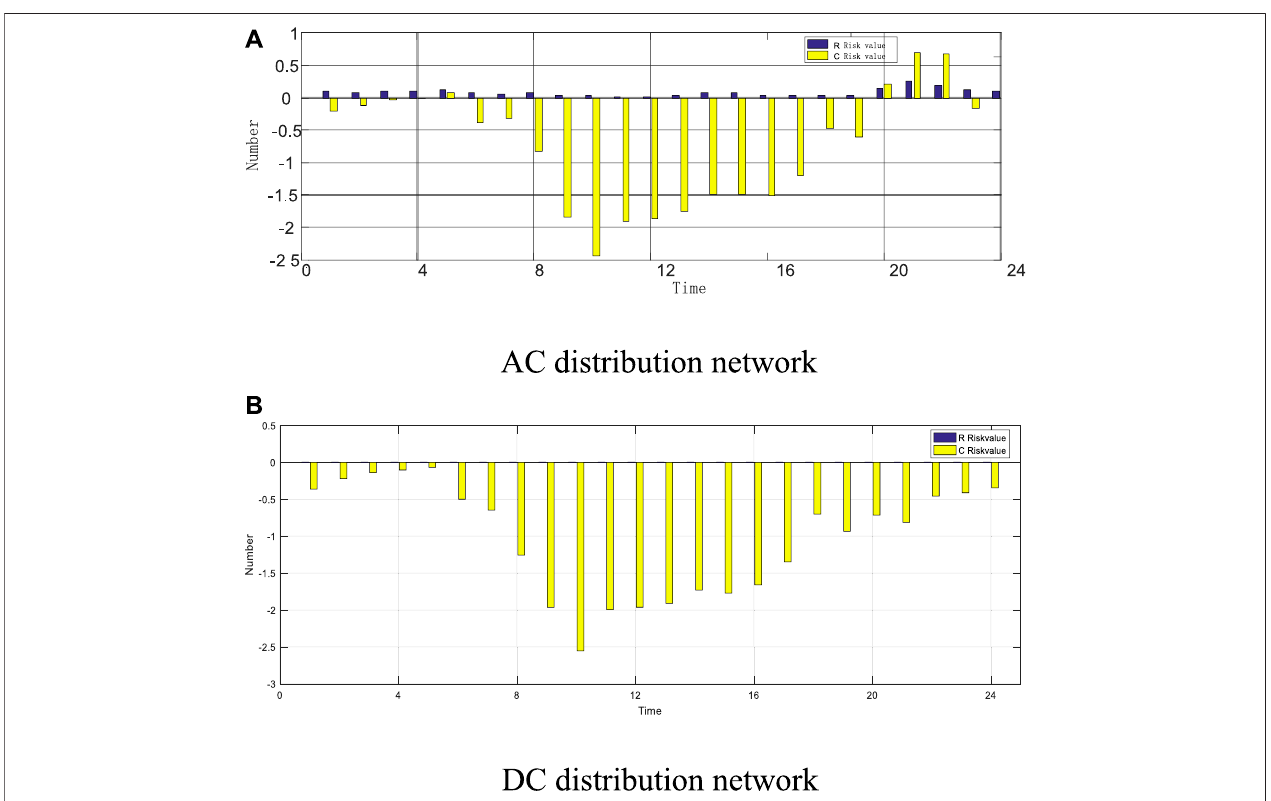
FIGURE 10 | ERI results of the distribution network: (A) AC distribution network. (B) DC distribution network.